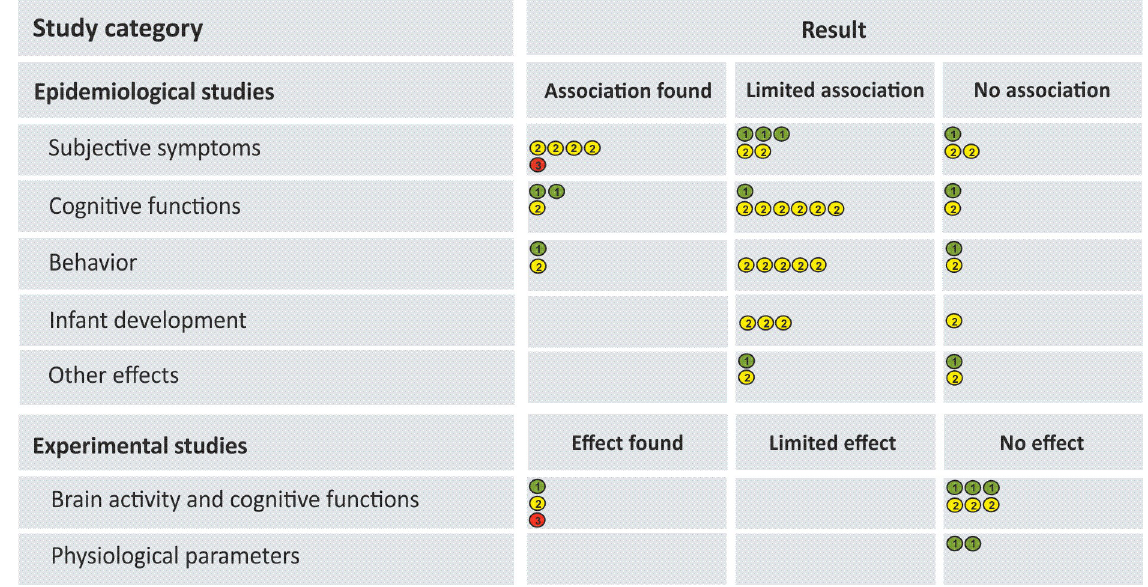
Fig 4. Overview of study quality and effects/associations found in the included studies. Each study is represented by a numbered and colored point, indicating the study quality assessed with the risk-of-bias tool recommended by OHAT [37, 39] (1/green = 1 st tier, 2/ yellow = 2 nd tier, 3/red = 3 rd tier). Each study is allocated to an effect category (columns) according to the conclusive result stated by the authors (cf. S4–S10 Tables). Please note that Roser et al. (2016) [45] investigated both cognitive functions and behavior and was therefore considered in both lines